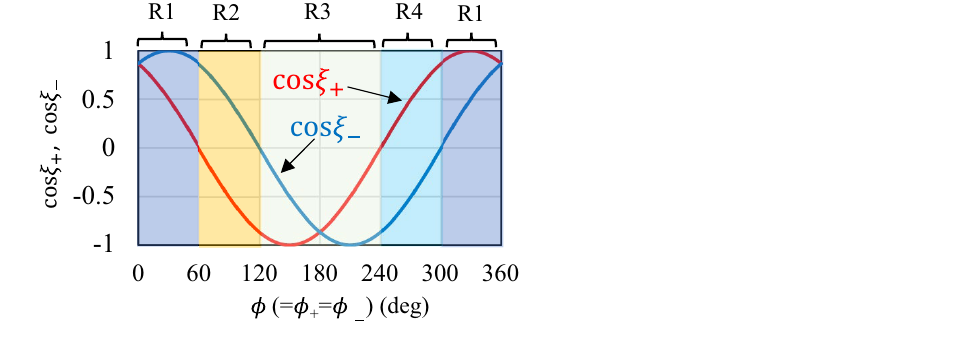
Figure 10. Relations among cos ξ + , cos ξ − , and φ (= φ + = φ −